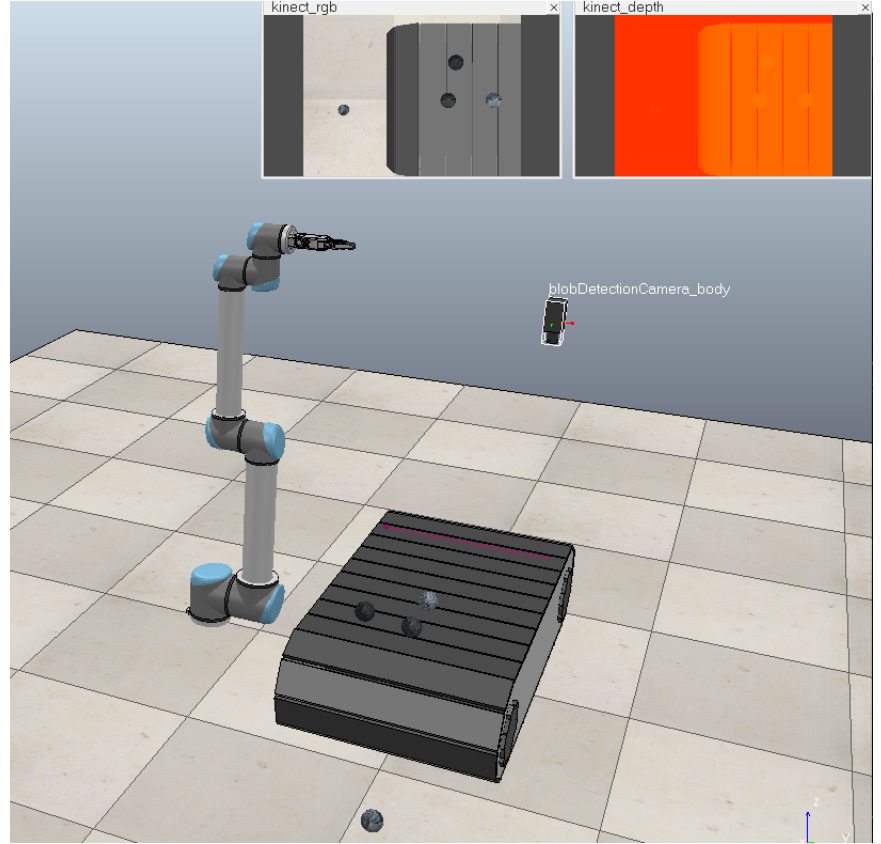
Figure 5. Simulation of coal gangue separating robot